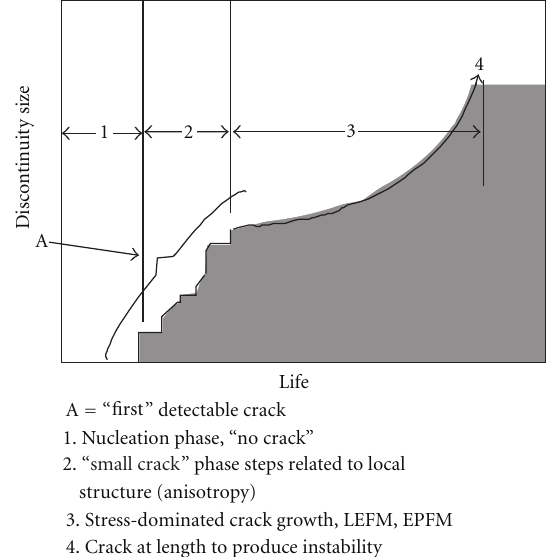
Figure 1: A depiction of the degradation process after Hoeppner- 1972 [67], 1981 [38], 1985